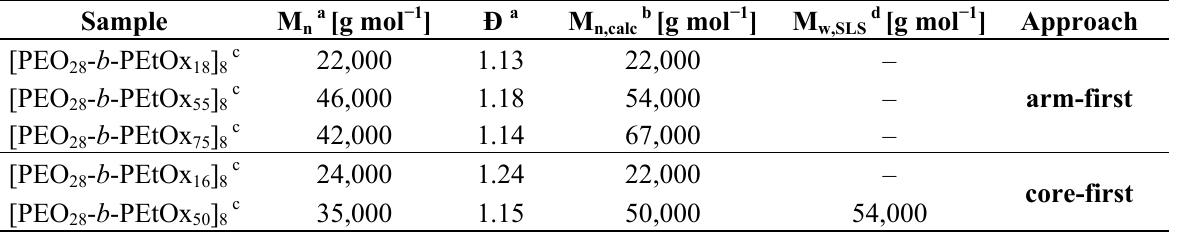
Table 2. Selected characterization data for star-shaped [PEO copolymers obtained via the “core-first” or “arm-first”